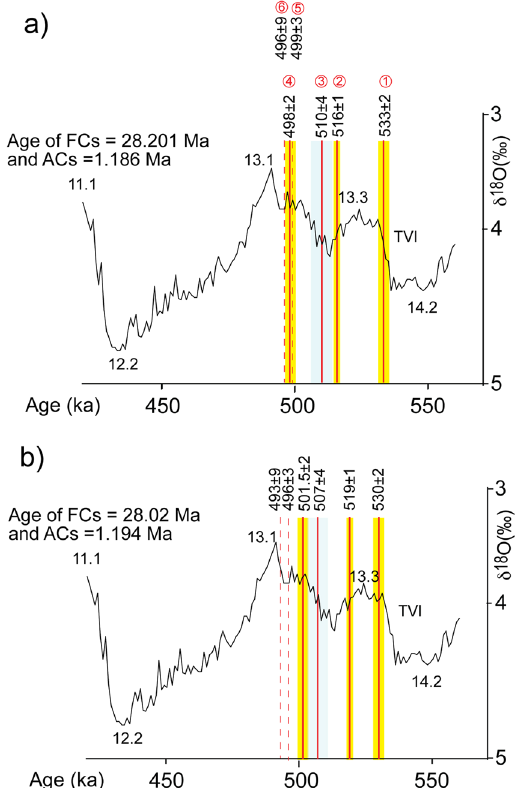
Figure 6. Position of the sample ages (1–6 in Fig. 5) on the astrocalibrated δ 18 O curve 12 , according to different calibrations of the standards (see text for comments). Red lines are the weighted mean ages of the dated samples (dashed lines represent ages providing no significant constraint). Yellow and grey boxes are the 2 σ full